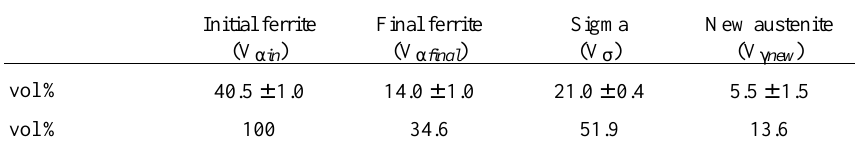
Table 8. The volumetric percentage of the existing phases in alloy AV2205 heat-treated at 850 °C for 1 h, under real conditions and under the supposition that the alloy is 100%